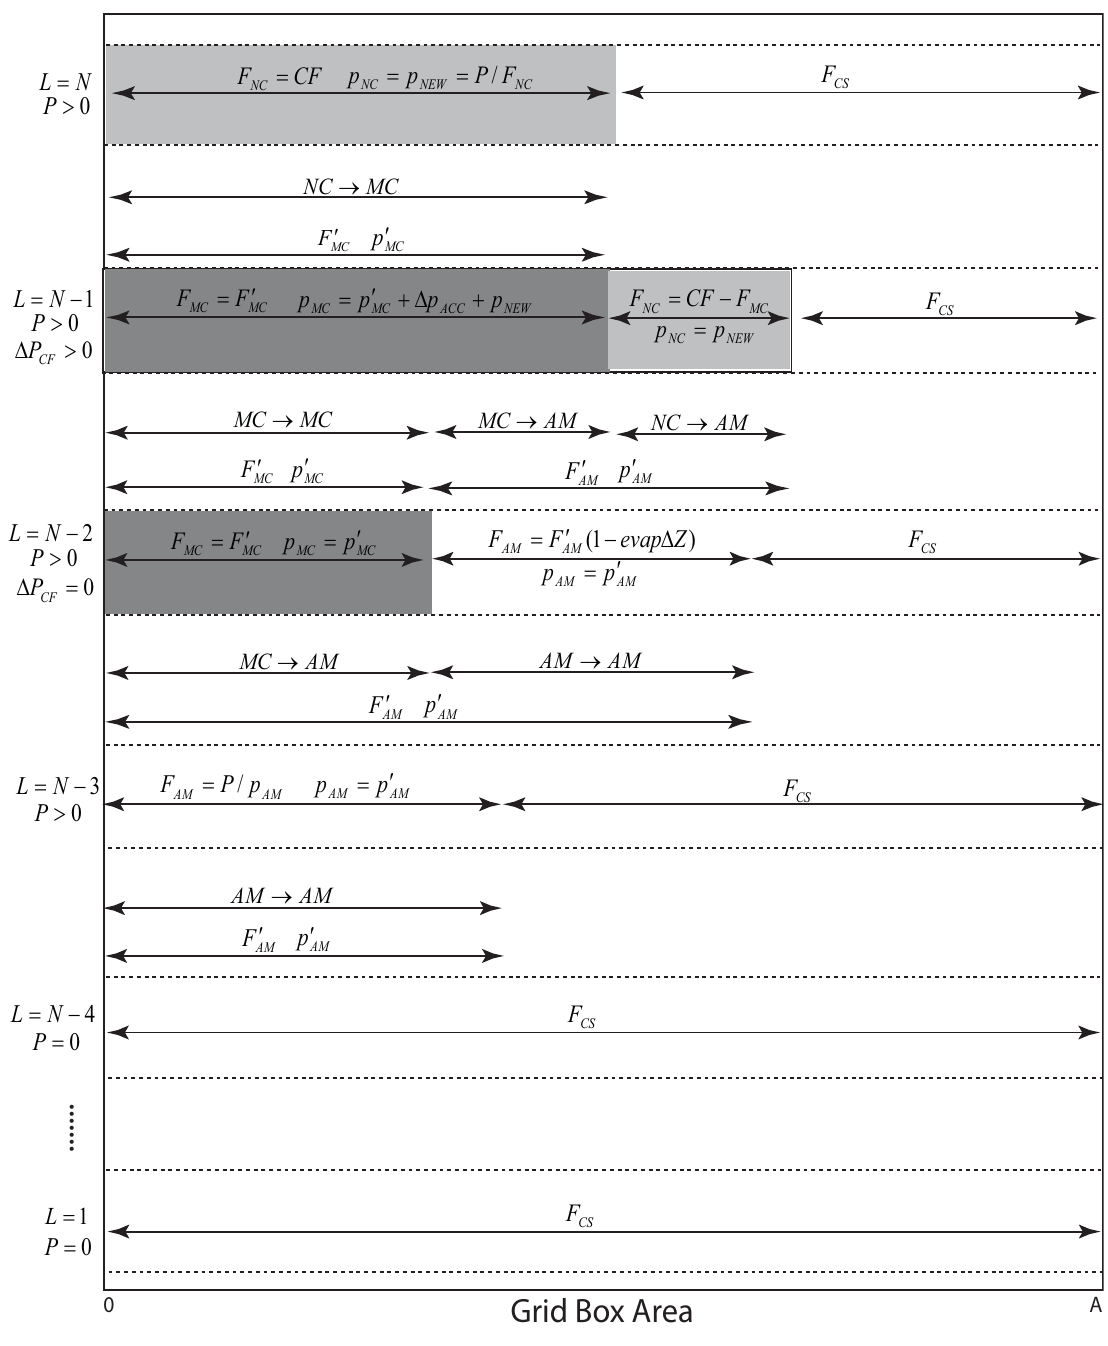
Fig. A1. Schematic of an idealized grid box with N levels, indicated by the horizontal dotted lines. The space between the levels is for illustrative purposes only. Levels N to N − 2 contain clouds (grey shaded areas) and Levels N to N − 3 have P(L)> 0. All gridbox fractions and precipitation rates are defined in the text and are shown for each level. The terms XX → YY indicate the gridbox fraction corresponding to ˆ f XX → YY as defined in the text (Eqs. A3 to A8). Level N is the first precipitating level, and the precipitating fraction and rate are given by Eqs. (A1) and (A21). Level N − 1 provides an example with CF (L) > CF (L + 1 ) , 1P CF > 0 (Eq. A18), and p NEW > 0 ( p MC and p NC given by Eqs. A27 and A28). Level N − 2 has CF (L + 1 ) > CF (L) and 1P CF = 0, with the standard evaporation in the ambient region sufficient to account for the decrease in P from level N − 1 to N − 2 (Eqs. A16 and A17). Level N − 3 has CF (L) = 0 and the decrease in P from level N − 2 to N − 3 exceeds the standard evaporation rate (Eq. A17). There is full evaporation of the precipitation in level N − 4 ( P(L) = 0 )